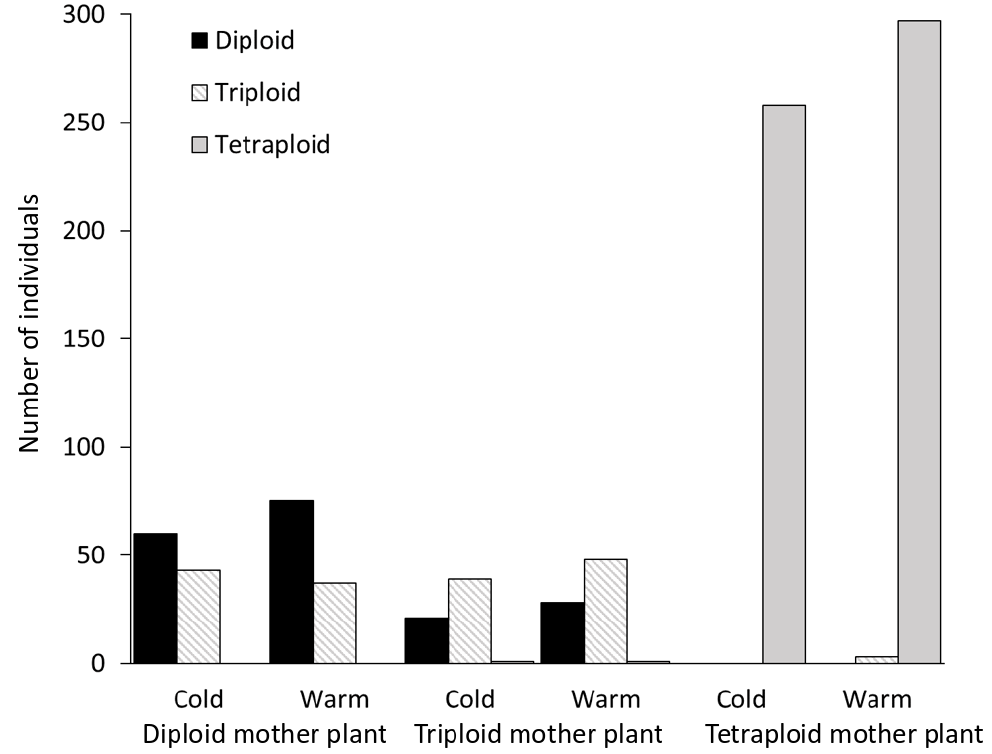
number of repetitions with 10 seeds per repetition; error bars = Standard Error (SE). Bars bearing the